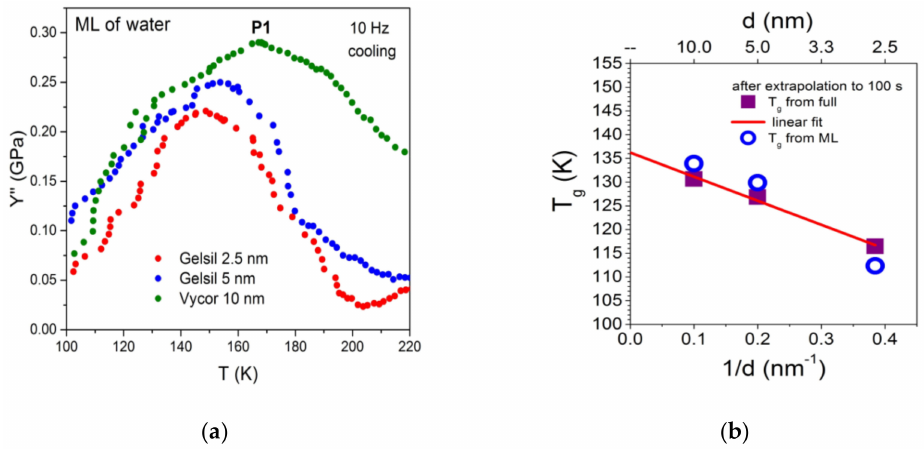
Figure 5. ( a ) Pore size dependence of the peak P1 for partly filled samples. The curves have been shifted for clarity. ( b ) Corresponding T g (d) values calculated from τ (T g ) =